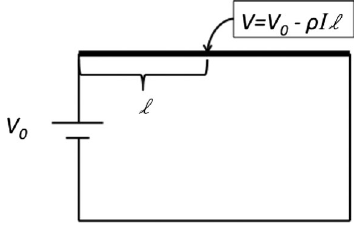
FIG. 11. Circuit for Appendix B, item